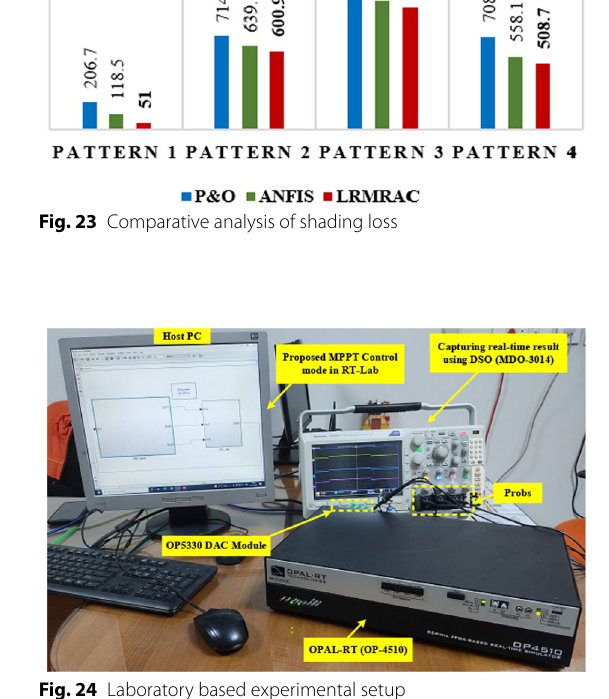
of the OPAL-RT simulator. Then an oscilloscope and OP5330 DAC are used to record the real-time results from the OP4510 simulator. On DSO, the signals including v pv , i pv, and p are observed and recorded in three different weather situations. Figure 25 shows the experimental results under varied radiation, Fig. 26 depicts the experimental outcomes under changing temperature and fixed radiation (1000 W/m 2 ), while Fig. 27 depicts the results with simultaneously varying